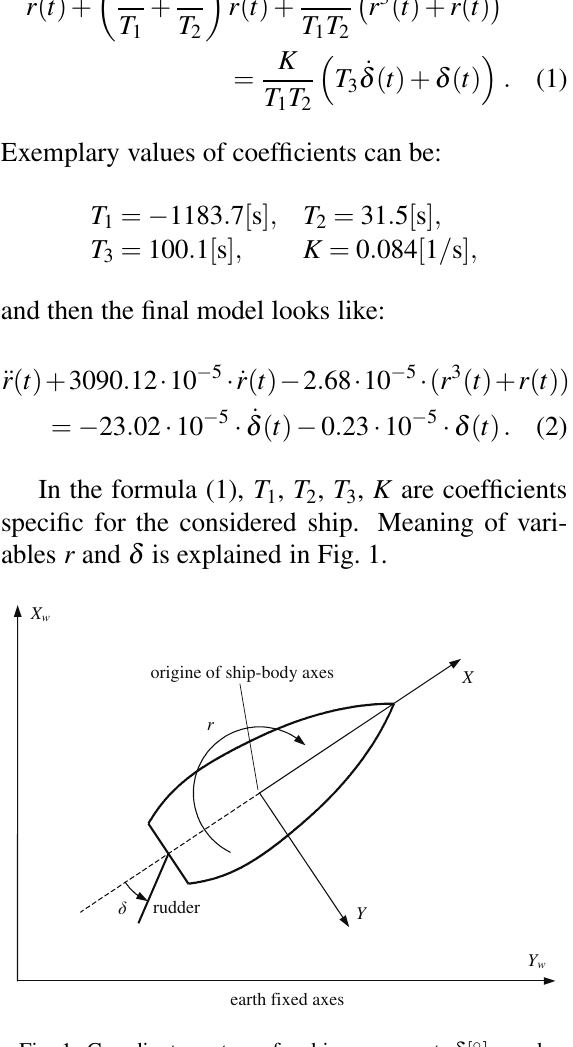
Fig. 1. Coordinate system of a ship movement, δ [ ◦ ] –